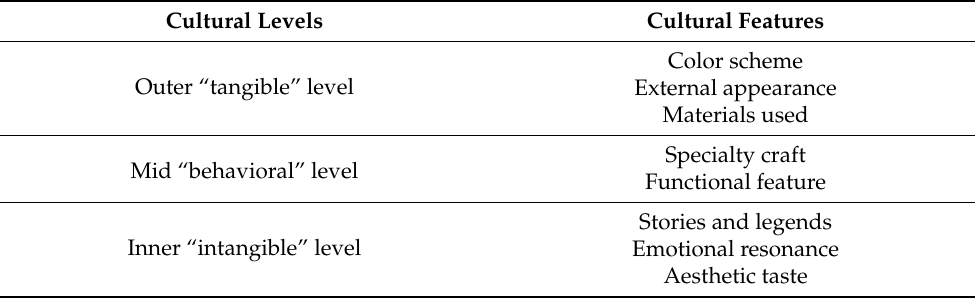
Table 1. Features of cultural and creative